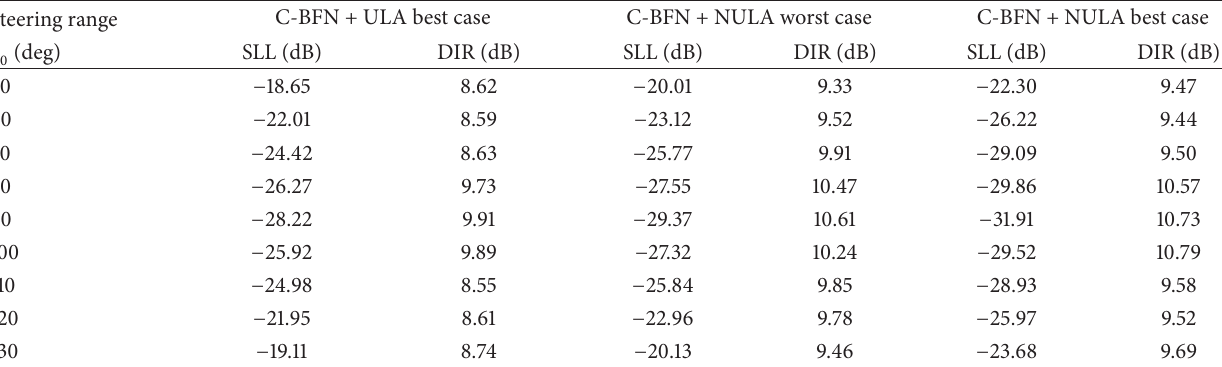
Table 2: Numerical values of side lobe level and directivity for the multiple beamforming network with a uniform and nonuniform linear array for beam number 1. Steering range